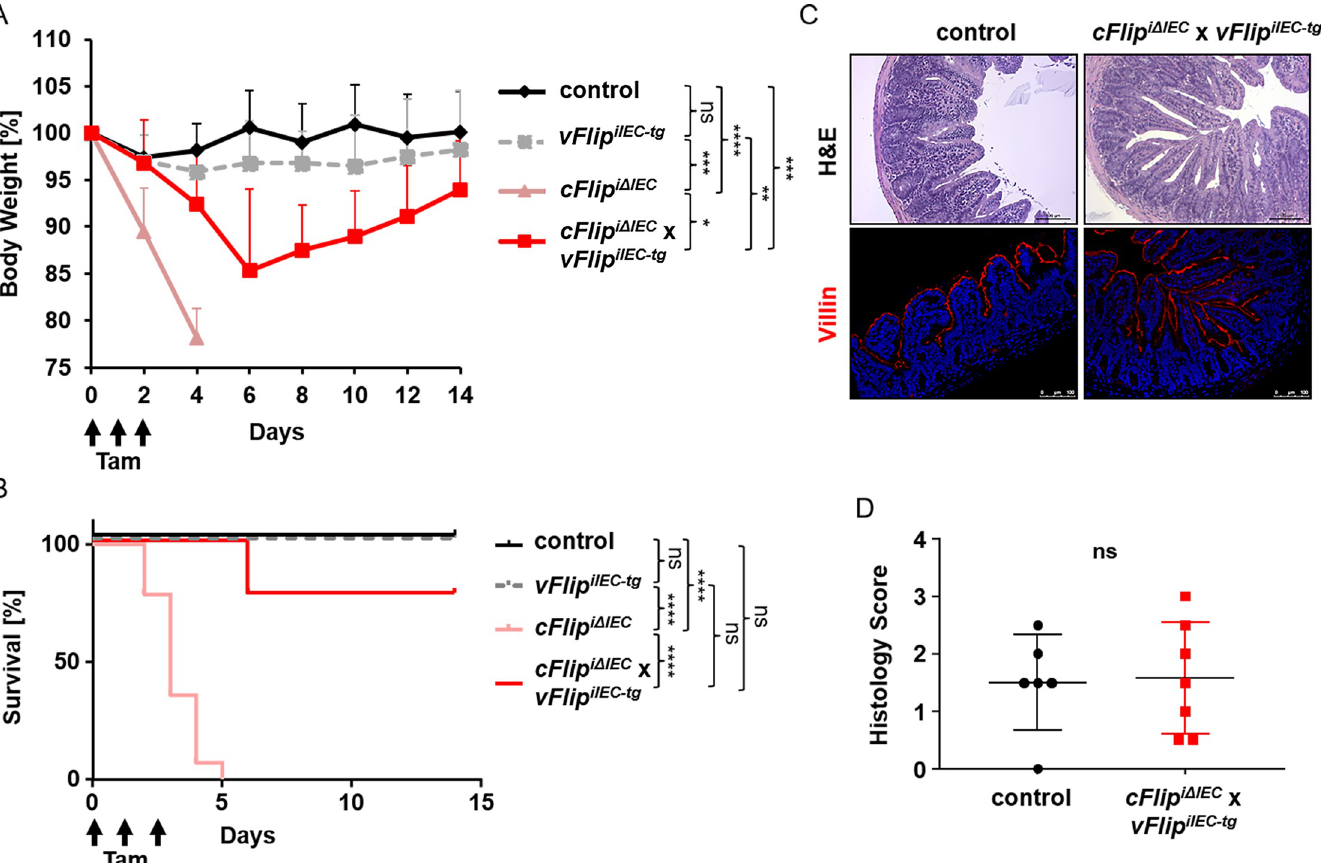
Fig 2. vFlip expression largely protects from lethality induced by cFlip deletion. (A) Kaplan-Meier Survival and (B) body weight curve of control (n = 10), vFlip iIEC-tg (n = 8), cFlip i Δ IEC (n = 13) and cFlip i Δ IEC x vFlip iIEC-tg (n = 9) mice injected with tamoxifen for 3 consecutive days. Mice were euthanized due to increased body weight loss ( > 20%) over the 14 days period upon tamoxifen treatment. (C) Representative picture of H&E and immunohistochemical staining of Villin (red) on cross sections of surviving control and cFlip i Δ IEC x vFlip iIEC-tg mice. Nuclei were counterstained with Hoechst 33342. Scale bar = 100 μ m. (D) Histology score of whole H&E stained cross sections of control (n = 6) and cFlip i Δ IEC x vFlip iIEC-tg (n = 7)